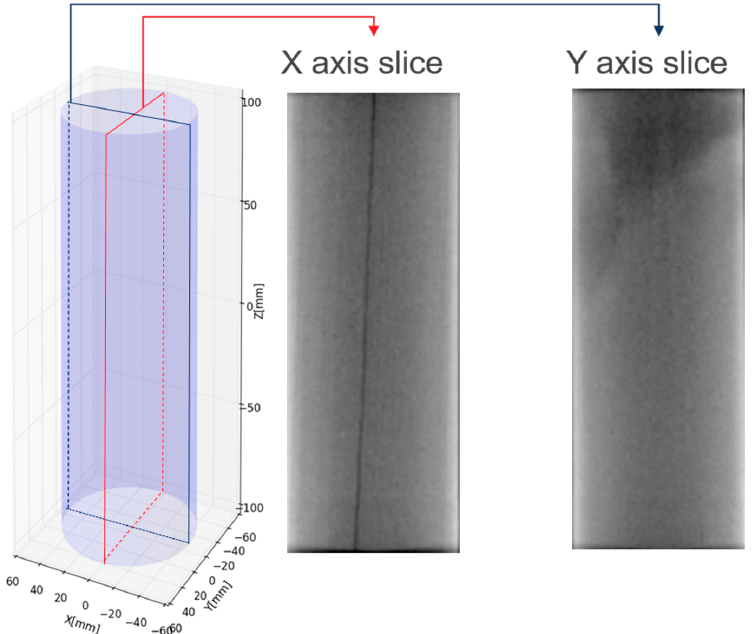
Figure 7. The original rock central position axial core CT scan images.